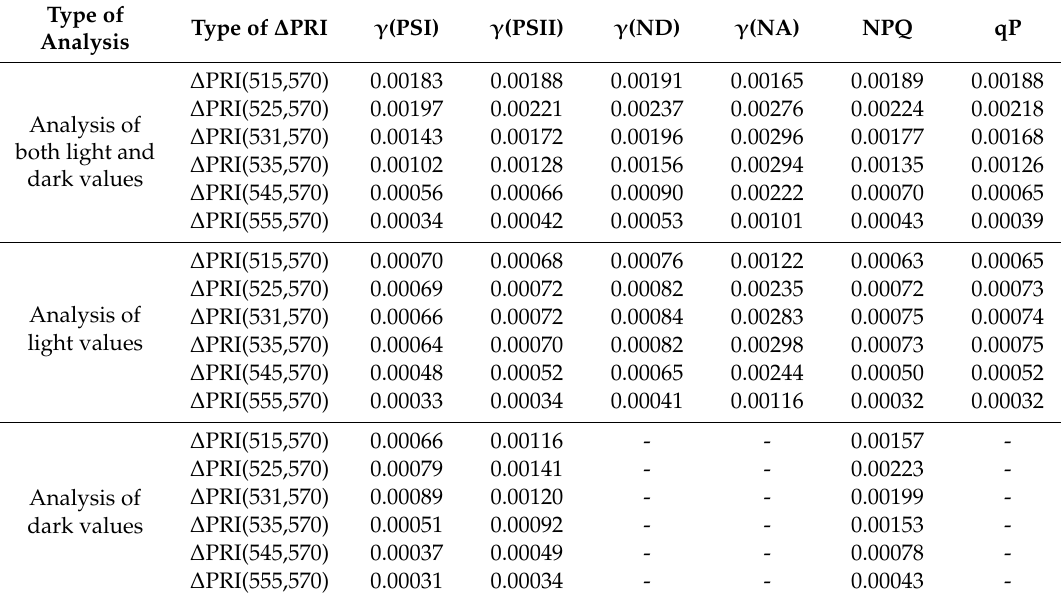
Table 1. Values of Root Mean Squared Error (RMSE), which were calculated on the basis of the linear regressions describing the relation of the ∆ PRIs to the photosynthetic parameters. The linear regressions were shown in Figures S1–S18 (Supplementary Materials). The light values were measured under actinic light; the dark values were measured without actinic